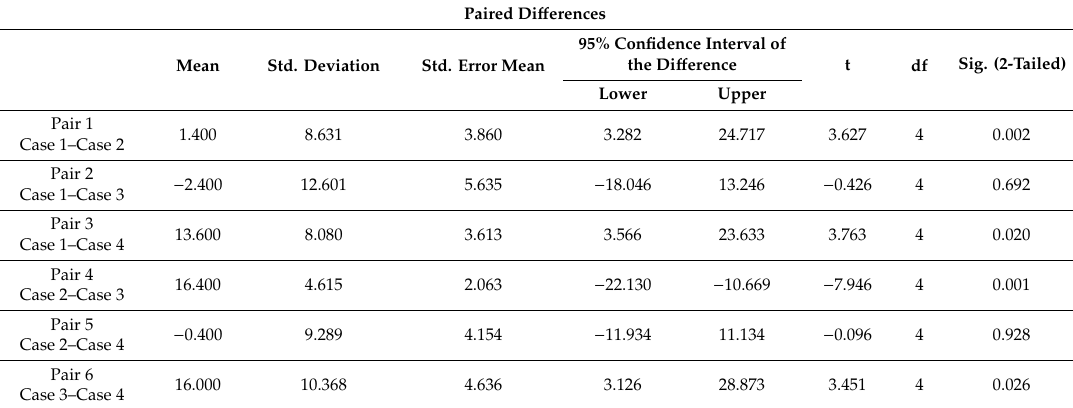
Figure 6. Comparison of salivary amylase activity values in di ff erent illumination environments. Table 5. T-test